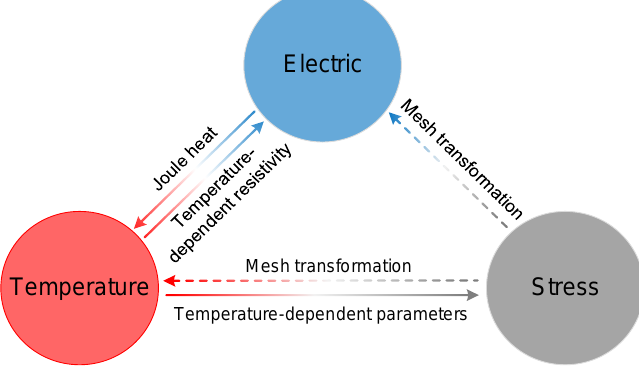
Figure 2. Schematic of multiphysics coupling.